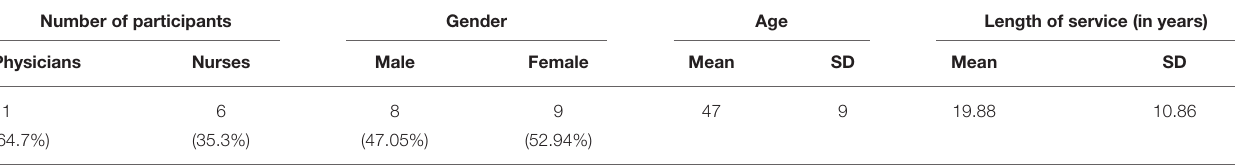
TABLE 1 | Participants’ characteristics.